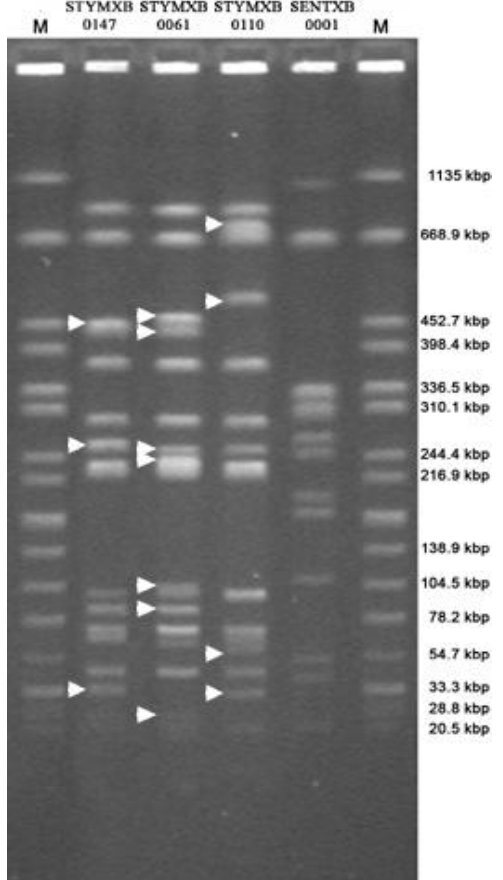
Figure 1. Pulsed field gel electrophoresis profiles exhibited by the Salmonella enterica strains analyzed in the current study. All representative profiles are included. Lines 1 and 6: universal standard, Salmonella serotype Braenderup H9812. Line 2: S. Typhimurium strain(s) R-type ACSSuT (pulsotype STYMXB.0061). Line 3: S. Typhimurium strain ST256 (R-type NxSSuT and pulsotype STYMXB.0110). Line 4: S. Typhimurium strain(s) pulsotype STYMXB.0147. Line 5: S. Enteritidis strain(s) pulsotype SENXB.0001. White arrows highlight restriction fragments distinguishing the pulsotypes